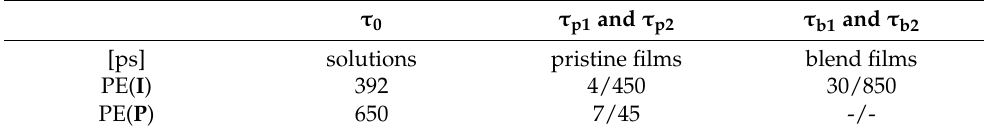
Table 2. Dominant spectroscopic lifetimes in picosecond time unit.